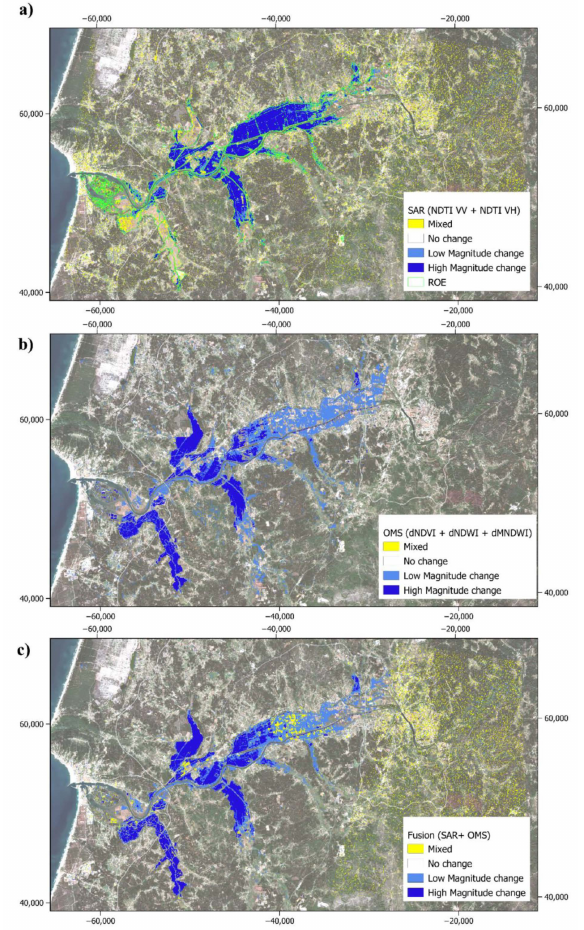
Figure 9. Flood-related change maps for the Mondego case study, obtained from the ( a ) OMS, ( b ) SAR, and ( c ) fusion datasets in comparison to the Reference Observed Event (ROE) [40] (coordinate reference system: PT-TM06/ETRS89). Table 8. Summary of the confusion matrix parameters and Matthews Correlation Coefficient (MCC) obtained for the Sindh Province floods, in comparison to the Reference Observed Event (ROE)